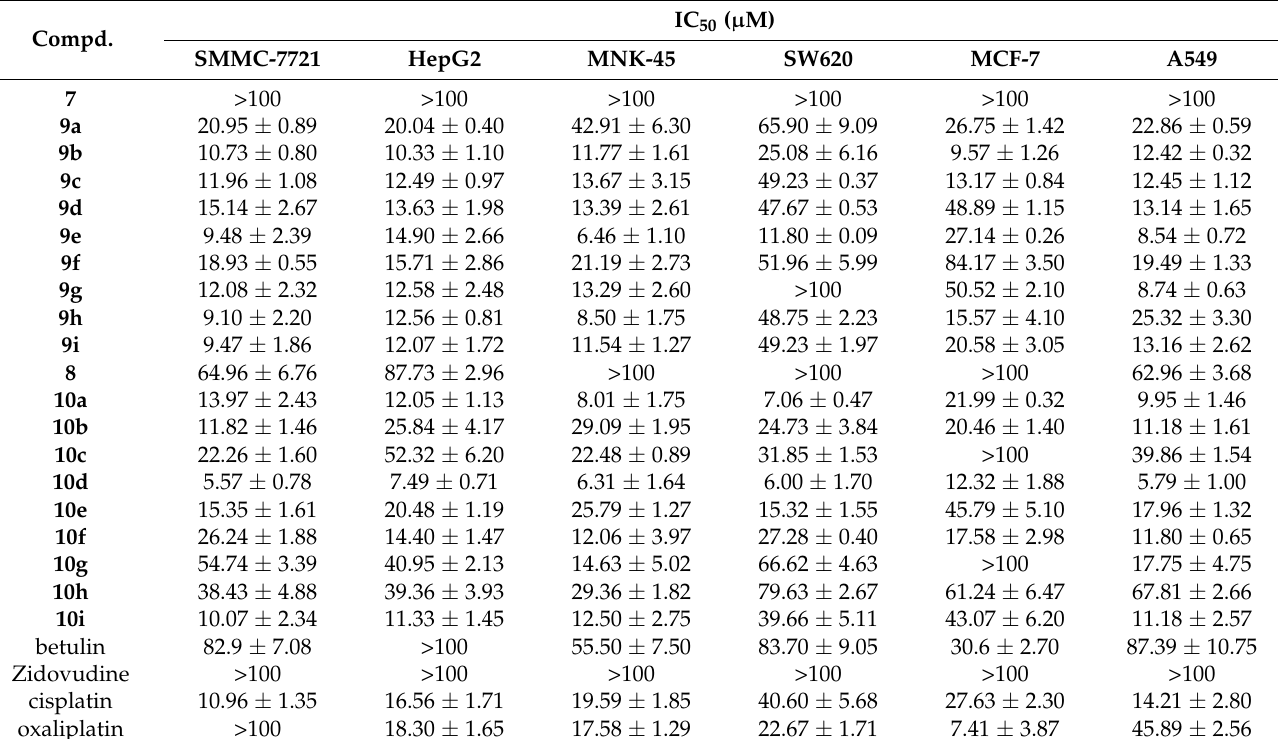
Table 1. Antineoplastic activities of compounds 7a – 8i , betulin, zidovudine, cisplatin, and oxaliplatin.